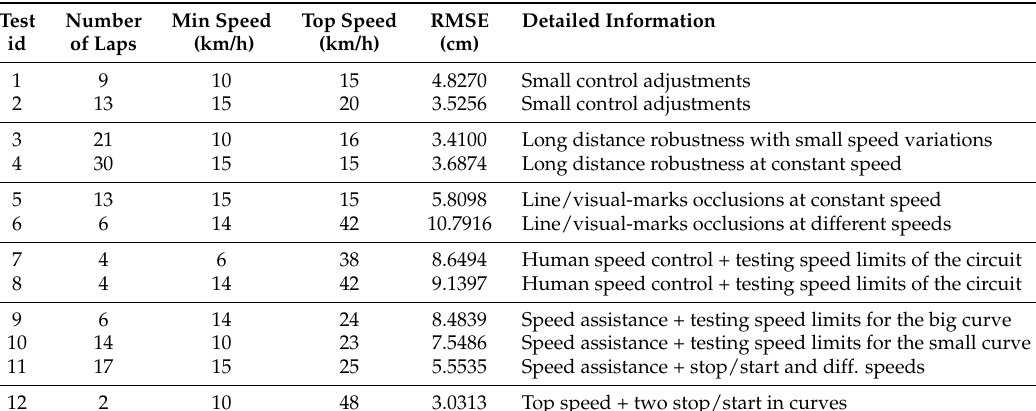
Table 2. RMSE evaluation of the different experiments done.